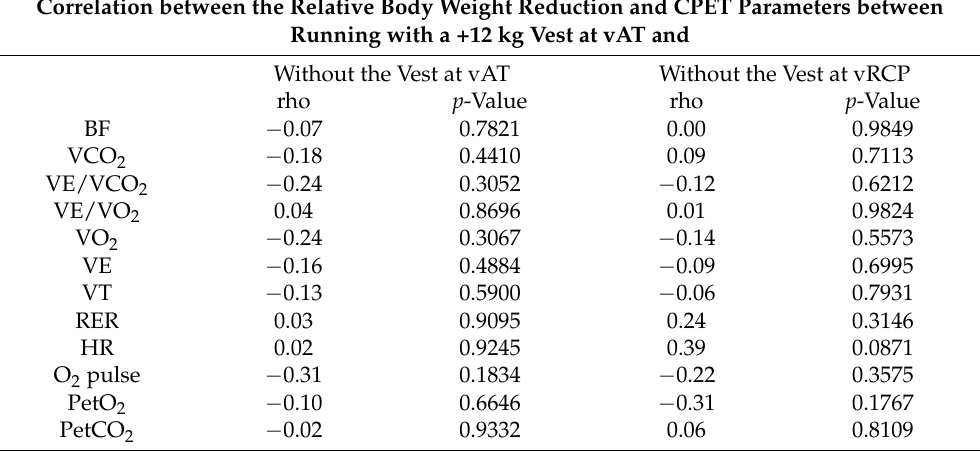
Table 6. Relationship of relative CPET parameter changes with the percentage simulated weight reduction. Correlation between the Relative Body Weight Reduction and CPET Parameters between Running with a +12 kg Vest at vAT and Without the Vest at vAT Without the Vest at vRCP rho p -Value